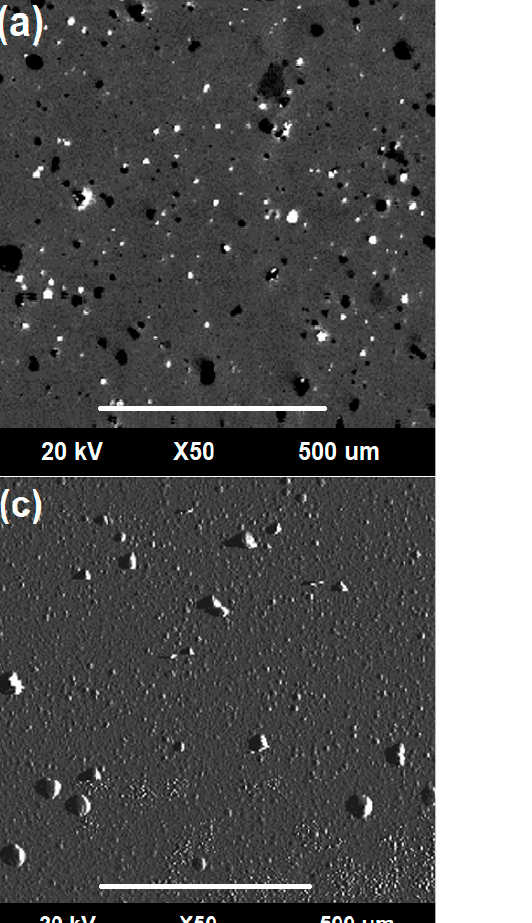
Figure 15. SEM micrographs after 90° impact angle corro-erosive testing for coatings ( a ) TaC, ( b ) HfC, ( c ) (Ta 70 -Hf 30 -C) and ( d ) (Ta 30 -Hf 70 -C).